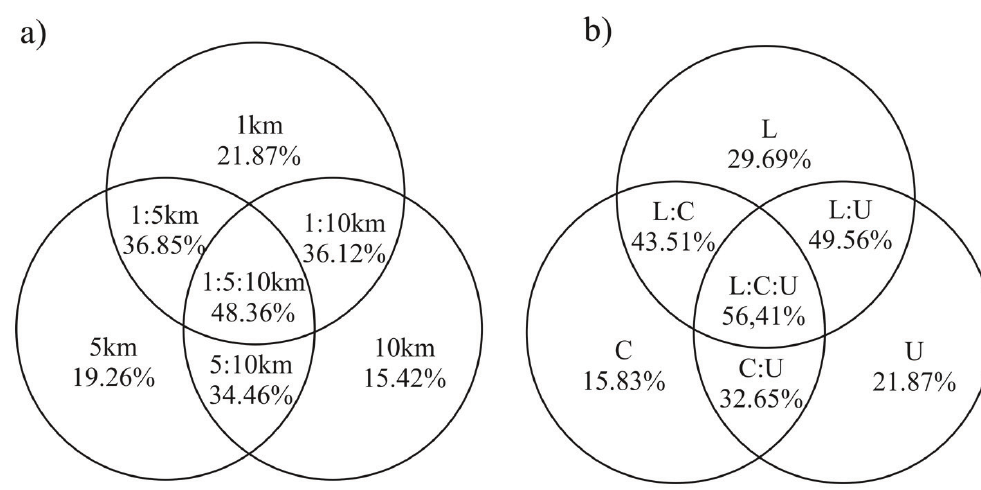
Figure 3. Spatial autocorrelation for species richness (Mantel correlogram) and composition (Moran’s I) in the Ivinhema River basin , Upper Paraná River, from 2001 to